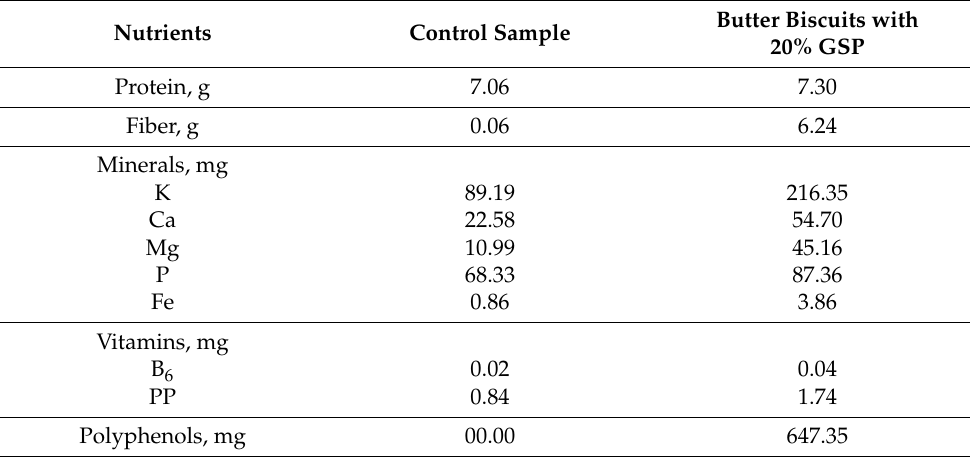
Table 4. The effect of grape seed powder on the nutritive value of butter